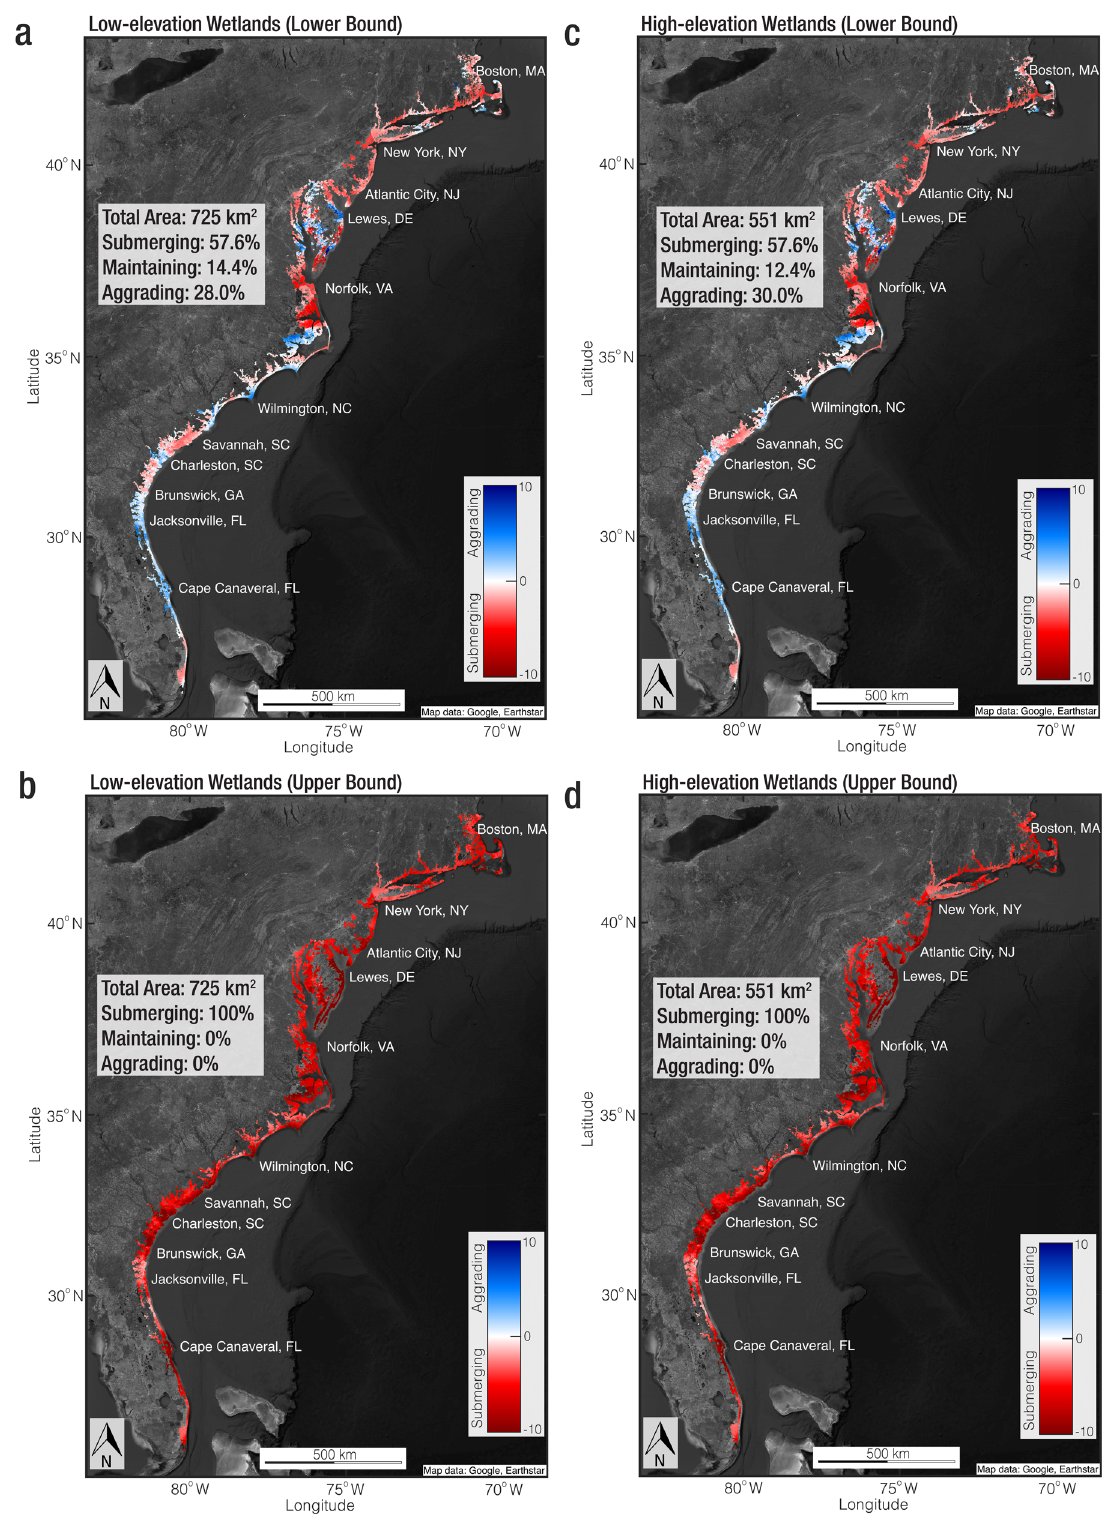
Fig. 5 | Wetland vulnerability across the US Atlantic coast. a Lower bound of vertical resilience (VR) for low-elevation wetlands (Background Image: Google, Earthstar). b Upper bound of VR for low-elevation wetlands (Background Image: Google, Earthstar). c Lower bound of VR for high-elevation wetlands (Background Image: Google, Earthstar). d Upper bound of VR for high-elevation wetlands (Background Image: Google, Earthstar). VR is calculated as vertical land motion (VLM)minussealevelrise.Theupperboundsandlowerboundsarecalculatedas±